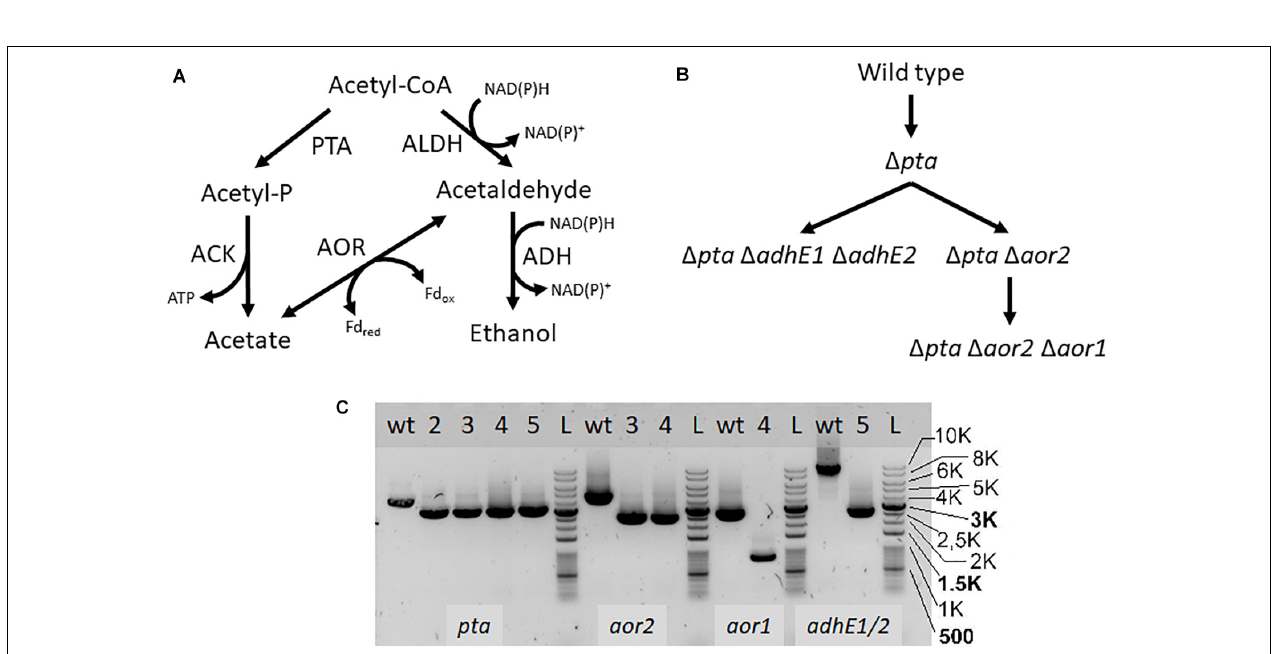
FIGURE 3 | Acetyl-CoA metabolism and creation of deletion mutants. PTA, phosphotransacetylase; ACK, acetate kinase; ALDH/ADH, aldehyde/alcohol dehydrogenase; AOR, aldehyde ferredoxin oxidoreductase (A) Map of acetyl-CoA metabolism with metabolites, cofactors, and enzyme reactions. (B) Strain map showing lineage of deletions made. (C) PCR confirmation of deletion strains. Primers were used to amplify the genomic regions of pta , aor2 , aor1 , adhE1, and adhE2 , to confirm genomic deletions. Lanes labeled with “wt” is wild type DNA control, while lanes with “L” are the DNA ladder. Lanes with numbers correspond to the following strains: 2- (cid:49) pta , 3- (cid:49) pta (cid:49) aor2 , 4- (cid:49) pta (cid:49) aor2 (cid:49) aor1 , 5- (cid:49) pta (cid:49) adhE1 (cid:49) adhE2 . The lower bands in the lanes correspond to expected gene deletions targeted by the homology arms.